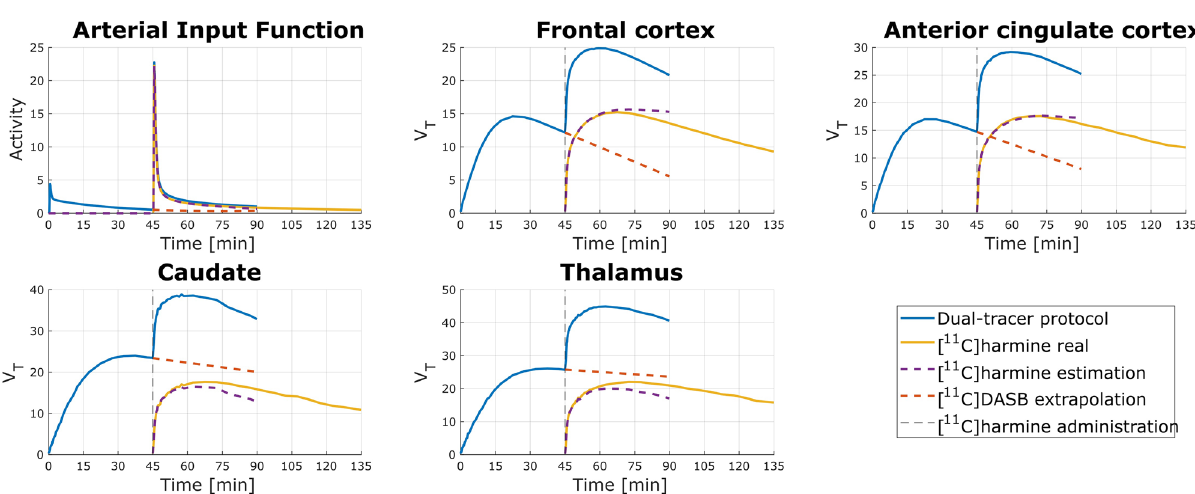
Figure 3. Example TACs and AIFs (top left) when [ 11 C]DASB was applied as first. Blue lines are representing dual-tracer application (TAC DASB_HAR and AIF DASB_HAR ), yellow lines are showing TAC HAR and AIF HAR of 90 min [ 11 C]harmine measurement, purple dashed lines shows a time course of estimated TAC HAR_est and AIF HAR_est and the red dashed line express extrapolated TAC DASB_ext and AIF DASB_ext . A black vertical dashed line denotes the administration of [ 11